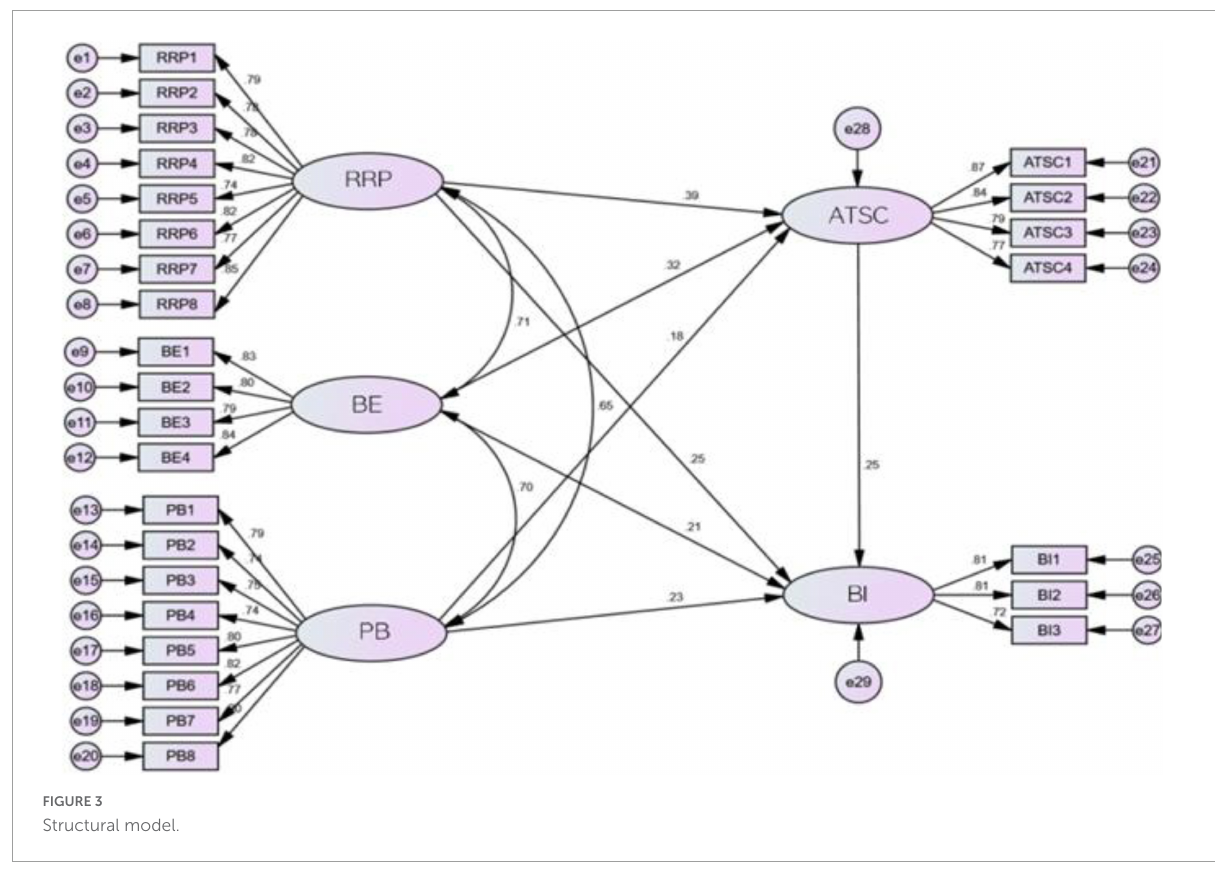
FIGURE3 Structural model.